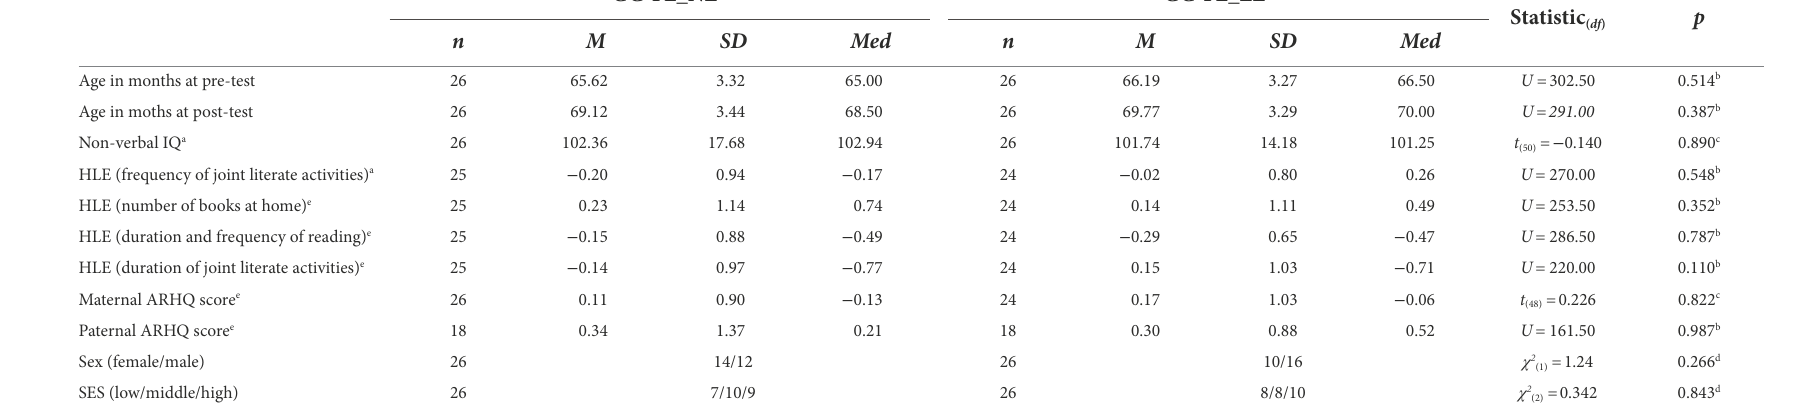
TABLE 2 Demographic characteristics of the GG-FL_NE and GG-FL_EE